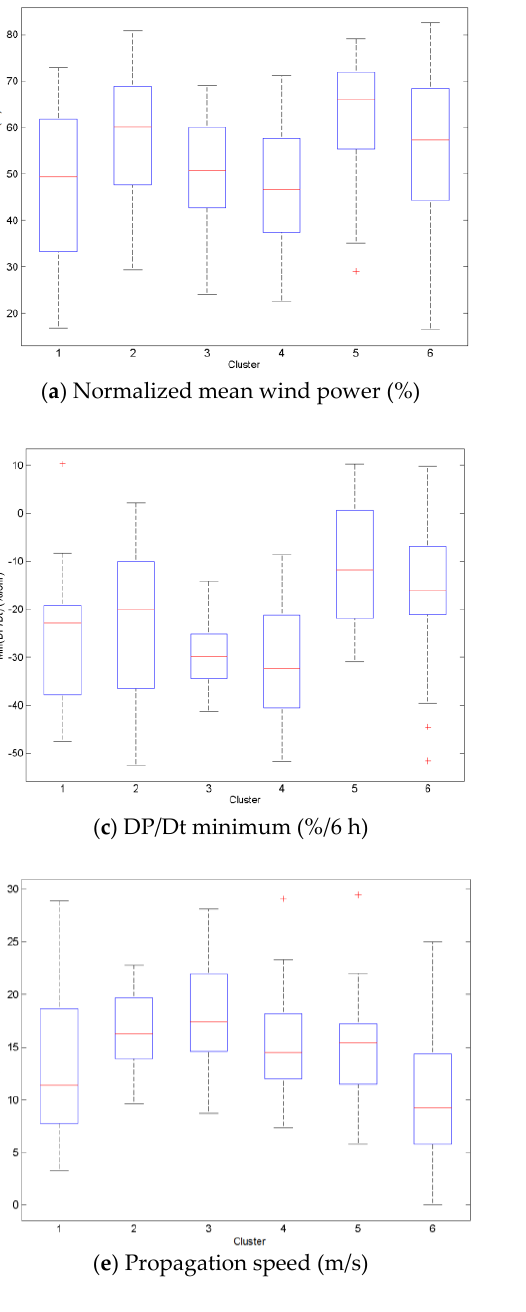
Figure 8. Main characteristics of the different trajectories clusters and their impact in the wind power production—Methodology 2.